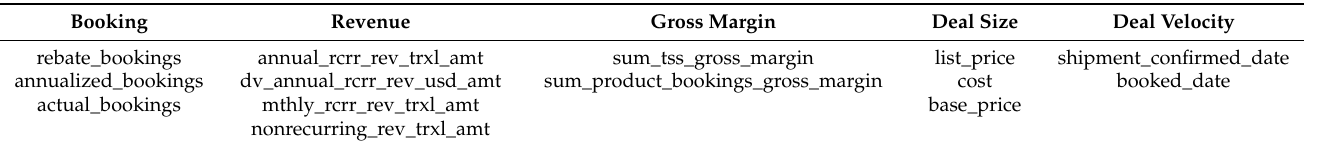
Table 4. Partners’ transformation attributes